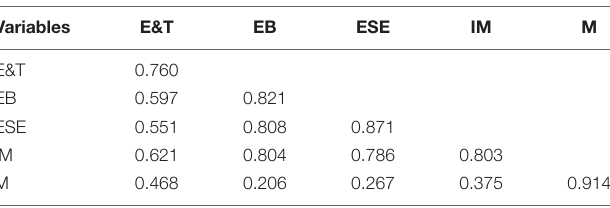
TABLE 3 | Fornell and Larcker criterion.